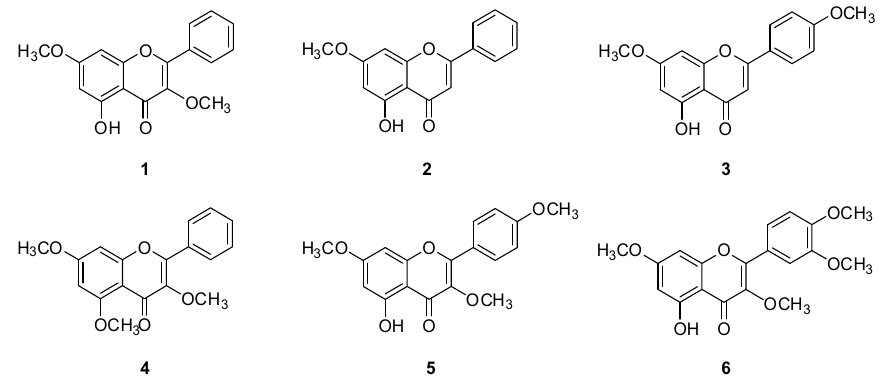
Figure 2. Chemical structures of Compounds 1 – 6 .